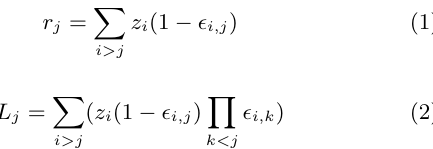
Figure 3: Simple Network